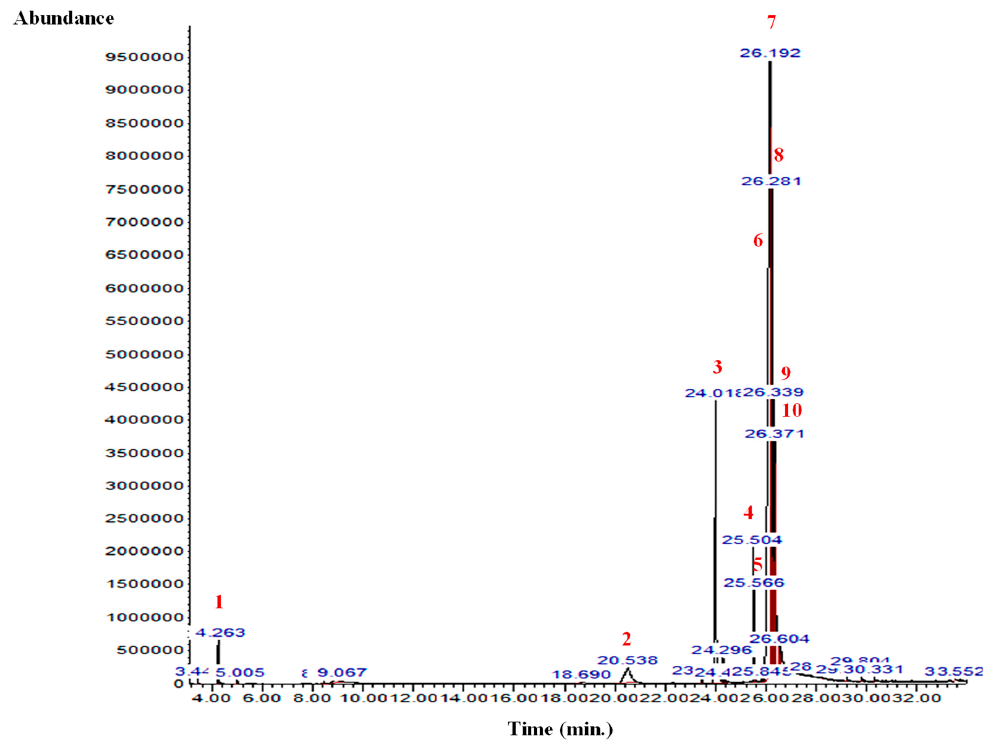
Figure 2. GC-MS chromatogram of the B . aegyptiaca seed aqueous extract. 1: Butane, 2-methyl-; 2: 3,4,6 -Tri-O-methyl-d-glucose; 3: 3,4,6 -Tri-O-methyl-d-glucose; 4: 9,12-Octadecadienoic acid (Z,Z)-;